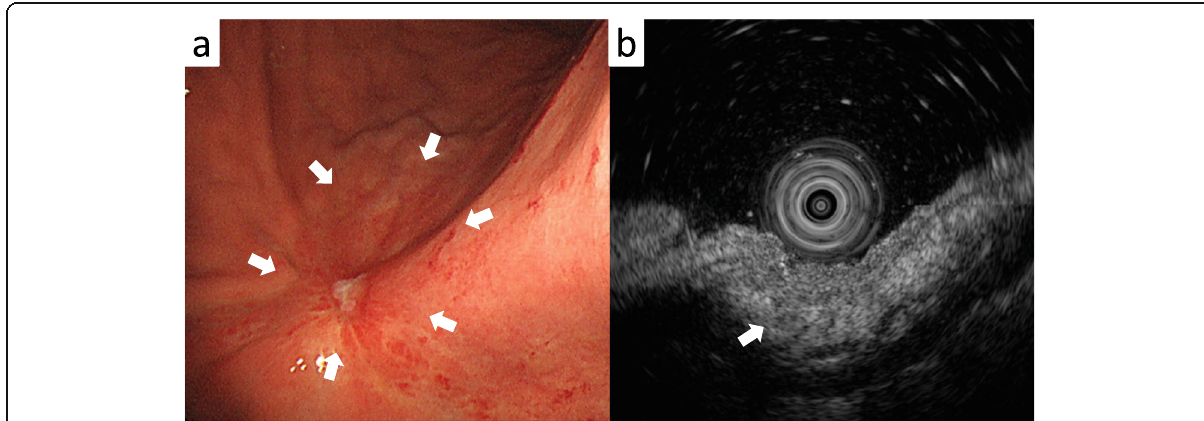
Fig. 1 Endoscopic findings. a Endoscopy image showing a type 0 – IIc lesion with an ulcer scar on the greater curvature side of the fundus (arrow). b Endoscopic ultrasound showing a poorly demarcated third layer at the ulcer scar